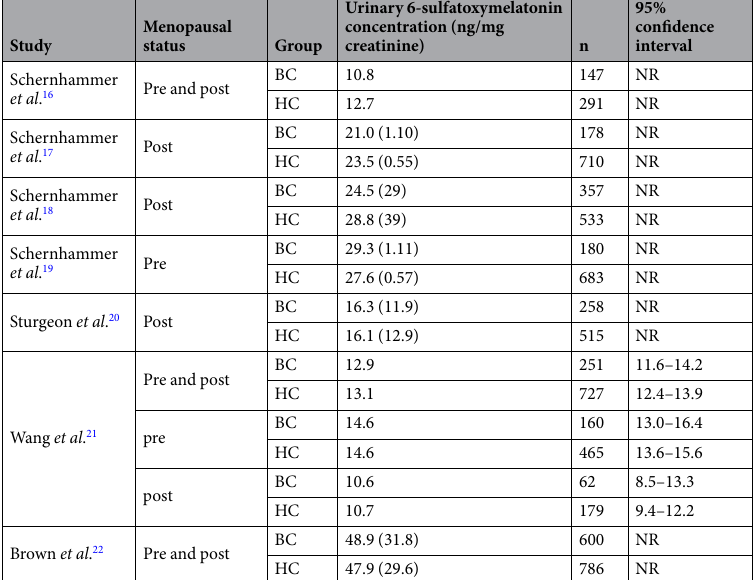
Table 3. Urinary 6-sulfatoxymelatonin concentration. BC, breast cancer; HC, healthy control; NR, not reported.